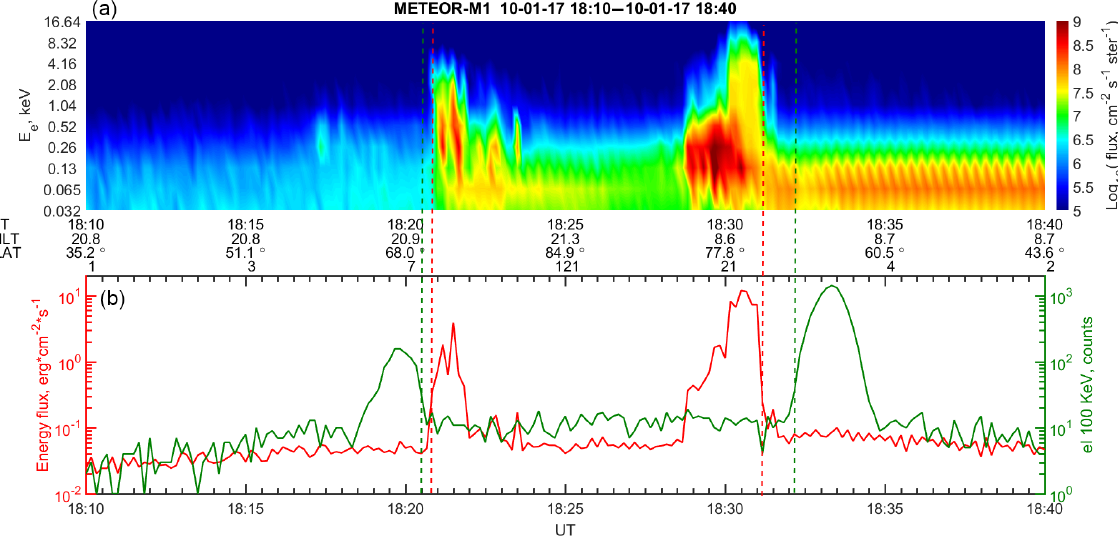
Figure 2. An example of observation of the polar boundary of ORB outside the auroral oval at AE < 150nT. The notations are the same as in Fig.